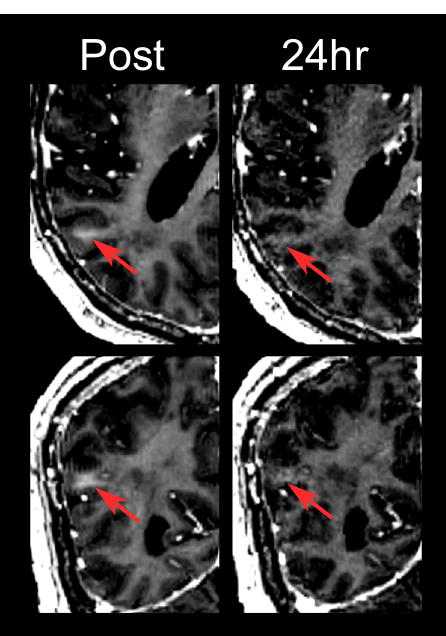
Fig. 2 Gadolinium-enhanced T1-weighted images: blood – brain barrier opening. Post: Blood – brain barrier opening of patient 2 in the targeted area immediately after sonication. 24 h: Same targeted area of patient 2, 24 h after treatment, without recognizable BBB opening. Top and bottom panels, respectively, show axial and coronal views of the parieto-occipito-temporal